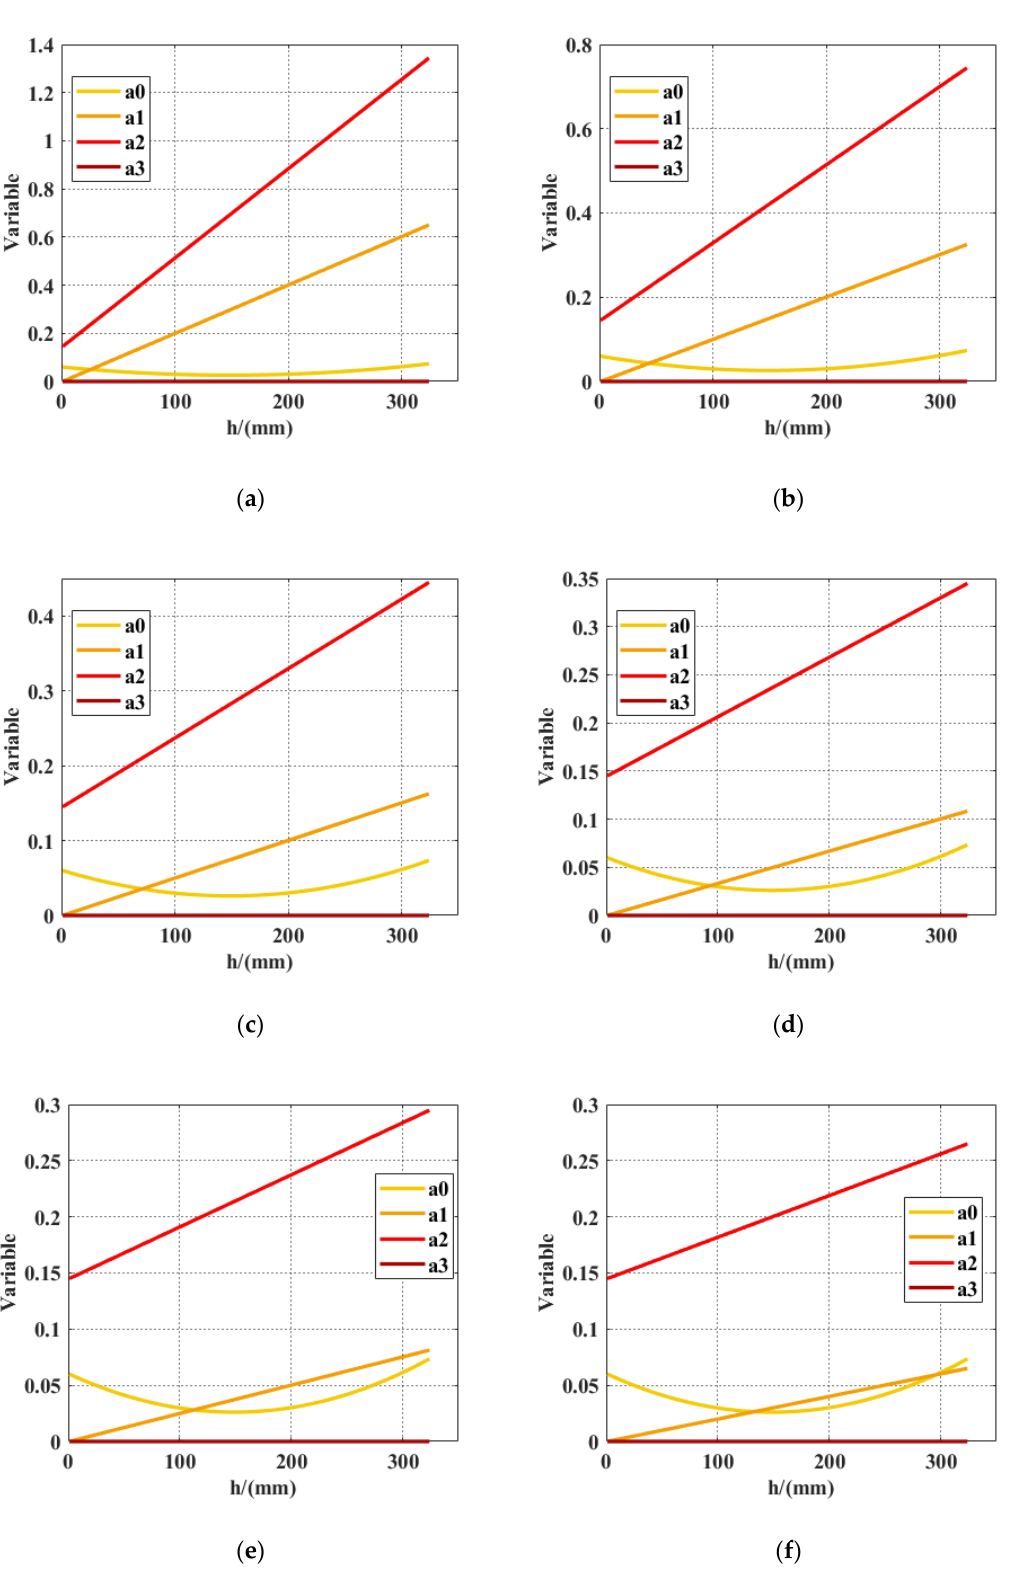
Figure 10. ( a ) Criterion variables at w 0 = 0.05 m/s; ( b ) Criterion variables at w 0 = 0.1 m/s; ( c ) Criterion variables at w 0 = 0.2 m/s; ( d ) Criterion variables at w 0 = 0.3 m/s; ( e ) Criterion variables at w 0 = 0.4 m/s; ( f ) Criterion variables at w 0 = 0.5 m/s .